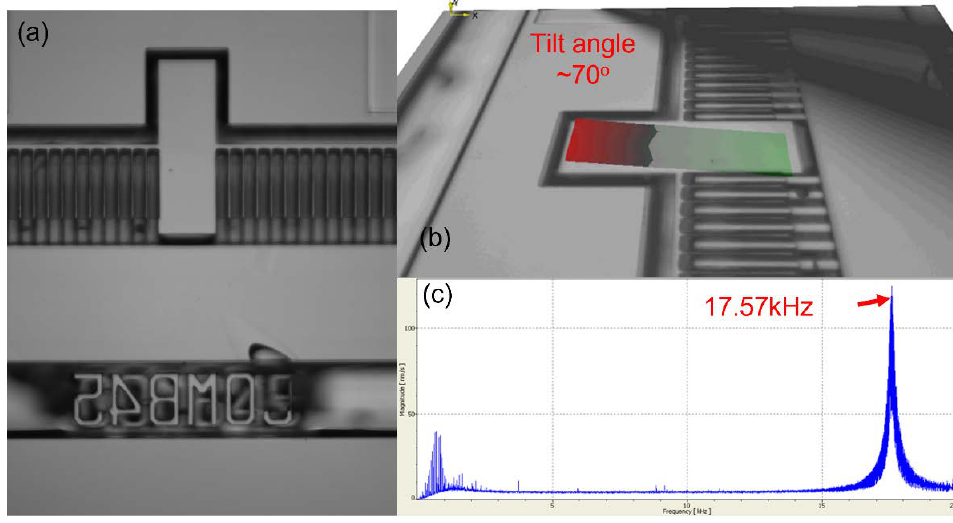
Figure 7. ( a ) SEM image of device ( b ) laser Doppler vibrometer results showing maximum tilt angle of 70° using AC bias of 2 V, ( c ) Fourier transform curve showing resonant frequency at 17.57 kHz.